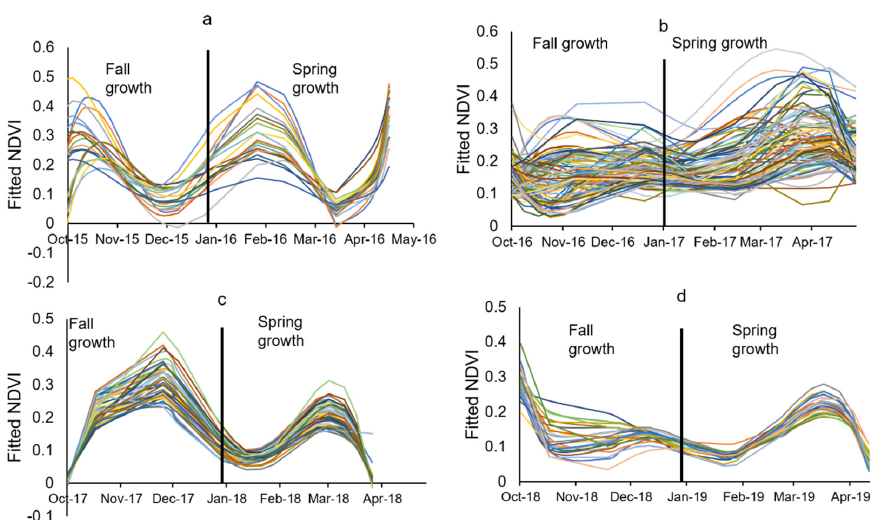
Figure 3. Second order harmonic analyses of NDVI based on 255 fields from Erie and Huron counties in 2015/16 ( a ), 2016/17 ( b ), 2017/18 ( c ) and 2018/19 ( d ).